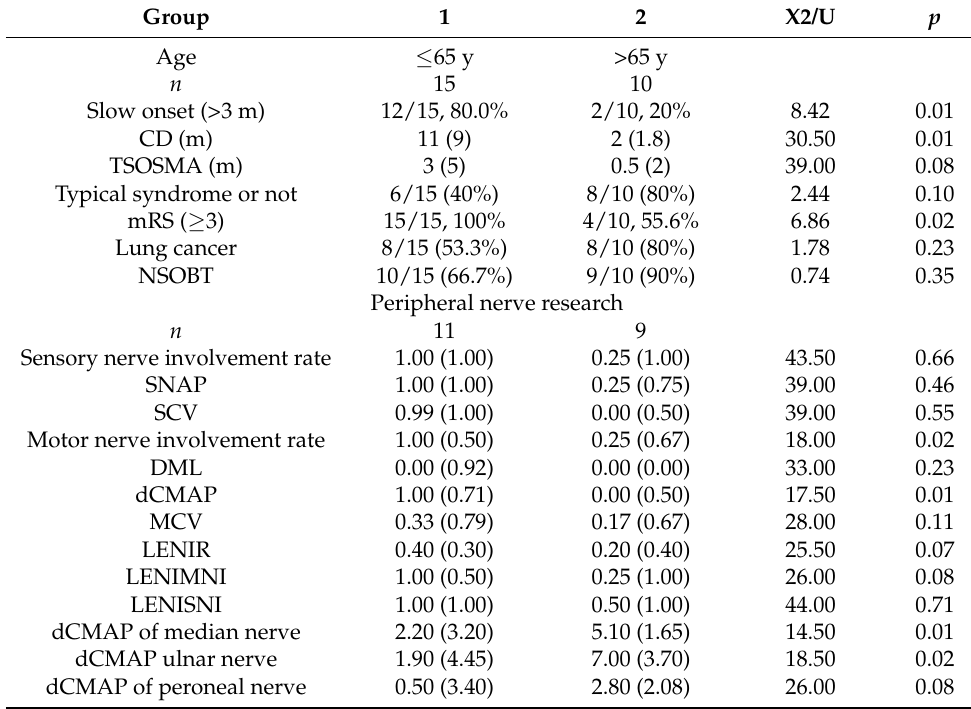
Table 2. Differences in disease course and electrophysiological results by age.